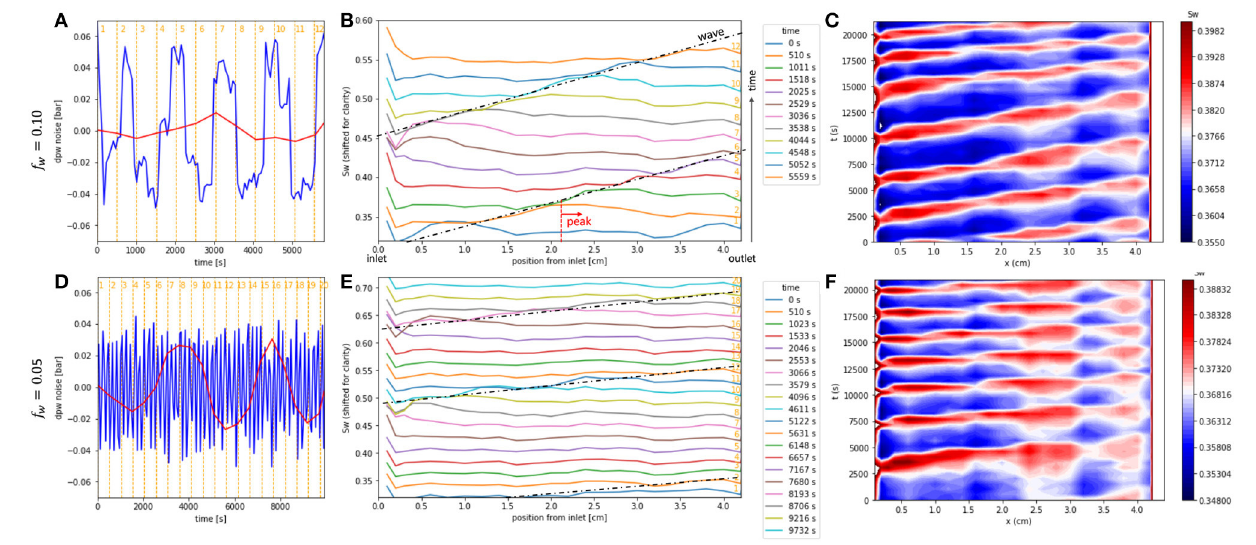
FIGURE 6 | Pressure and saturation fluctuations for f w = 0.10 (limited range, 0–5700s from Figure 2D ) (A) and f w = 0.05 (D) showing pressure data in blue and saturation data (sampled at much lower frequency) in red. Respective saturation profiles ( B,E , which have been vertically shifted for clarity) exhibit a water saturation peak, which moves from inlet to outlet at constant velocity, forming a traveling wave, which repeats one the peak reaches the outlet. The wave structure in (B,E) has been emphasized by adding the dashed black lines. The wave structure is better visible in the space-time contour plots in (C,F) . For f w = 0.10 the wave velocity is = 0.75 mm / min and for f w = 0.05 the wave velocity is between 1.7 and 2.1 v S w